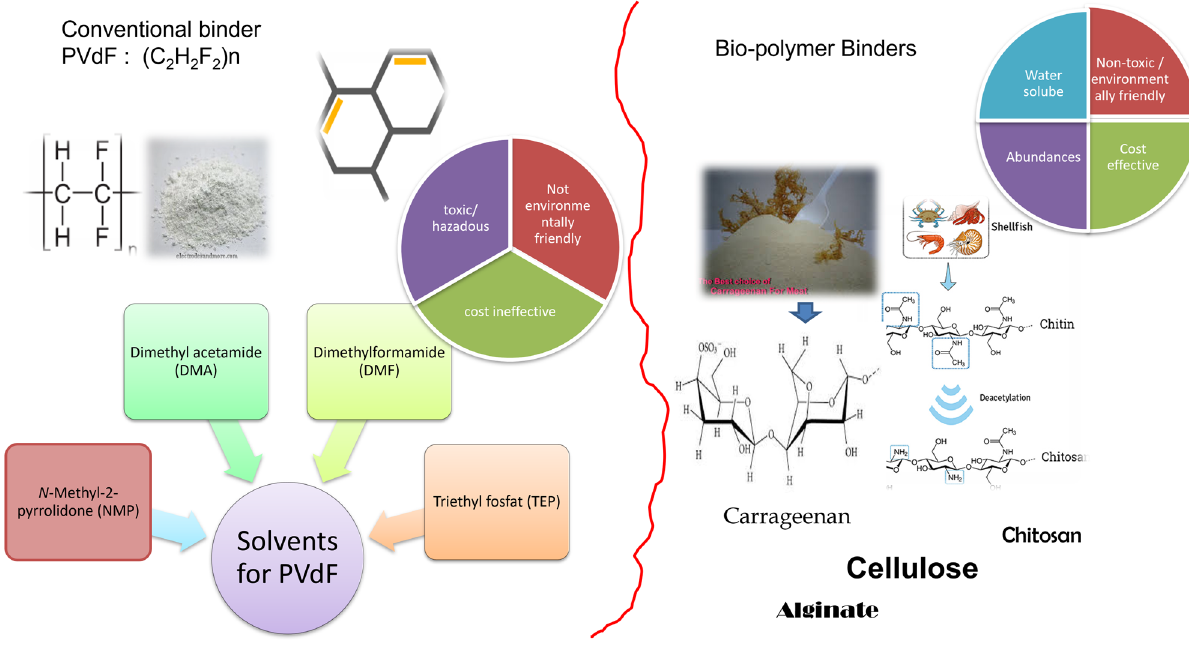
Figure 11: Varieties of binders applied in electrode composition for Li - ion